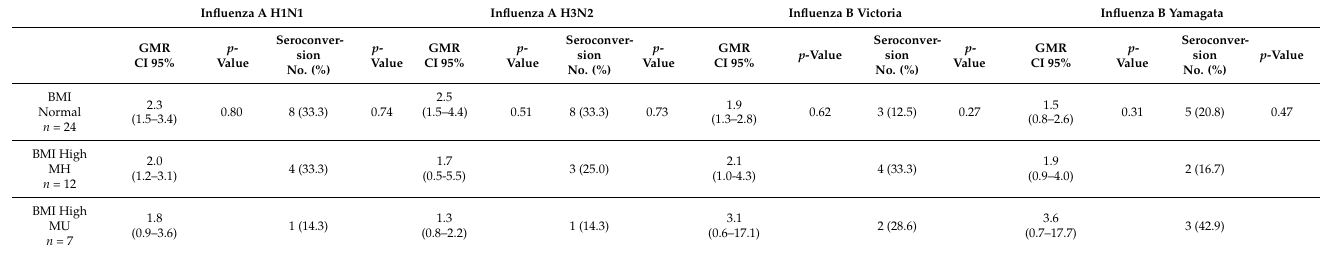
Table 4. Antibody responses 25–42 days after vaccination against influenza A/H1N1cand H3N2 and influenza B/Victoria and Yamagata lineages in the general cohort and according to BMI and metabolic status. A total of 43 patients had complete follow-up and serum samples were collected both before and after vaccination. From these 43 samples, 24 were classified as BMI normal, 12 samples as BMI high MH (metabolic healthy) and 7 samples as BMI high MU (metabolic unhealthy).